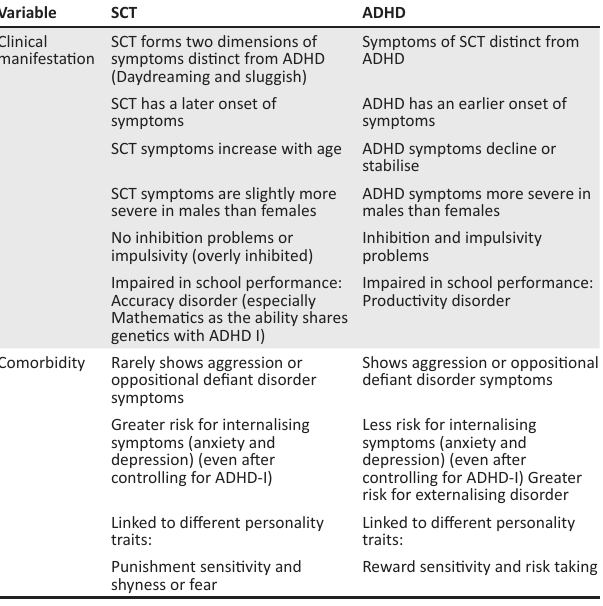
TABLE 1 : Differences between sluggish cognitive tempo versus attention deficient hyperactivity disorder. Variable SCT